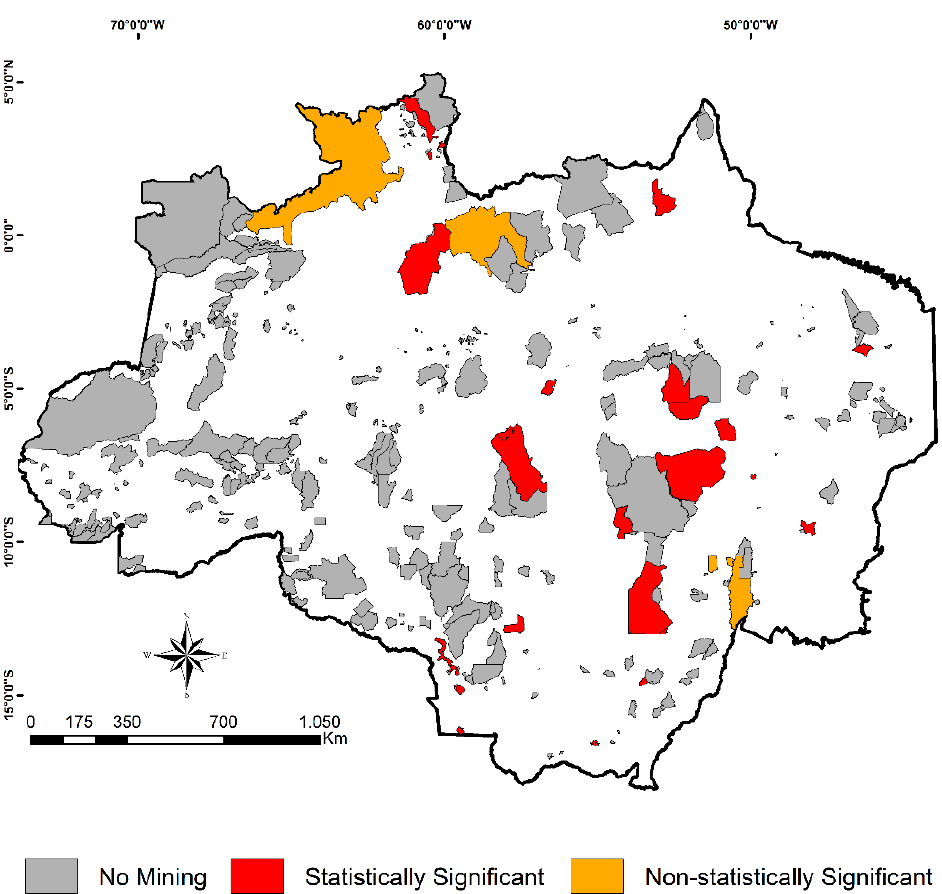
Figure 4. Spatial distribution of the result obtained after applying the Mann–Kendall test to the mining activity time series of the 31 Indigenous Lands of the Brazilian Legal Amazon where mining activity was detected in at least one of 36 years analyzed.